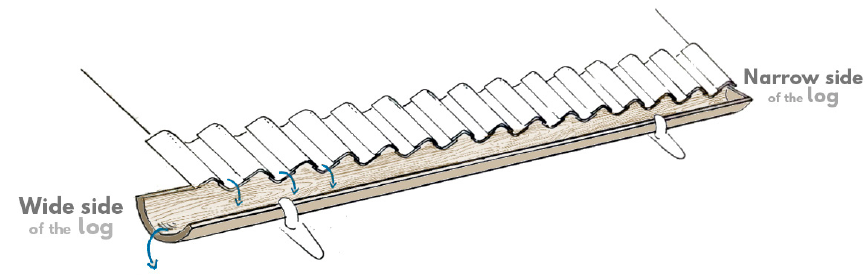
Figure 7. Rainspout made by pine or spruce log (re-illustrated from Özgüner (1970)).